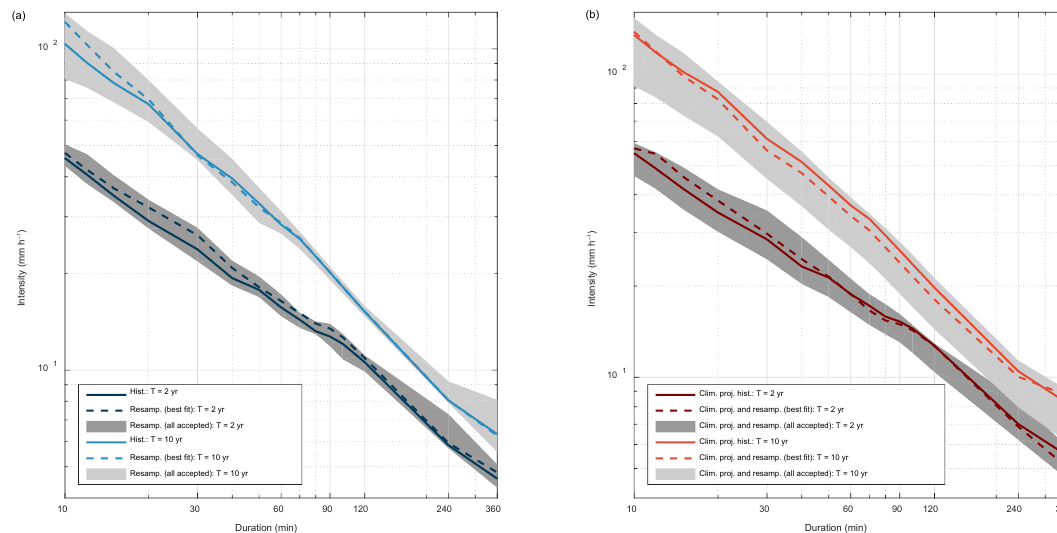
Figure 5. IDF curves for historical and resampled rainfall series (a) and climate-projected historical and resampled series (b) .